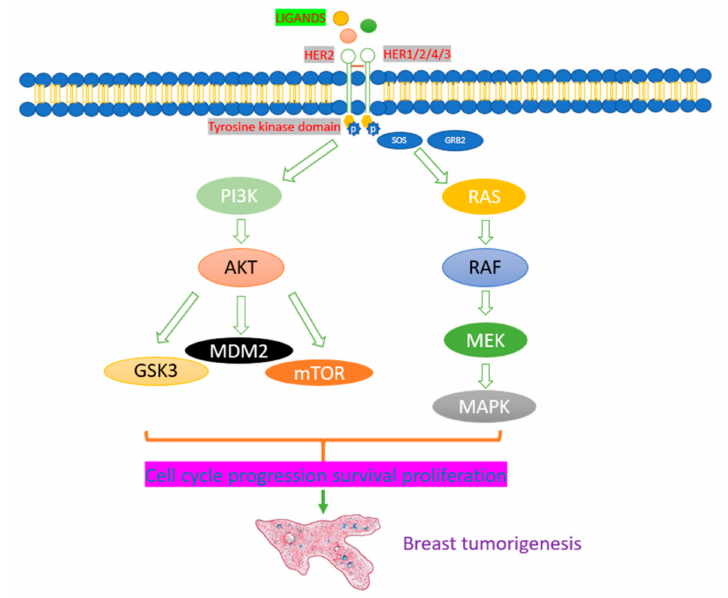
Figure 2. Pathophysiology of breast cancer. HER2 and other tyrosine kinase receptors present on the cell membrane and join to ligands. Tyrosine kinases undergo phosphorylation and start signaling pathways such as AKT and